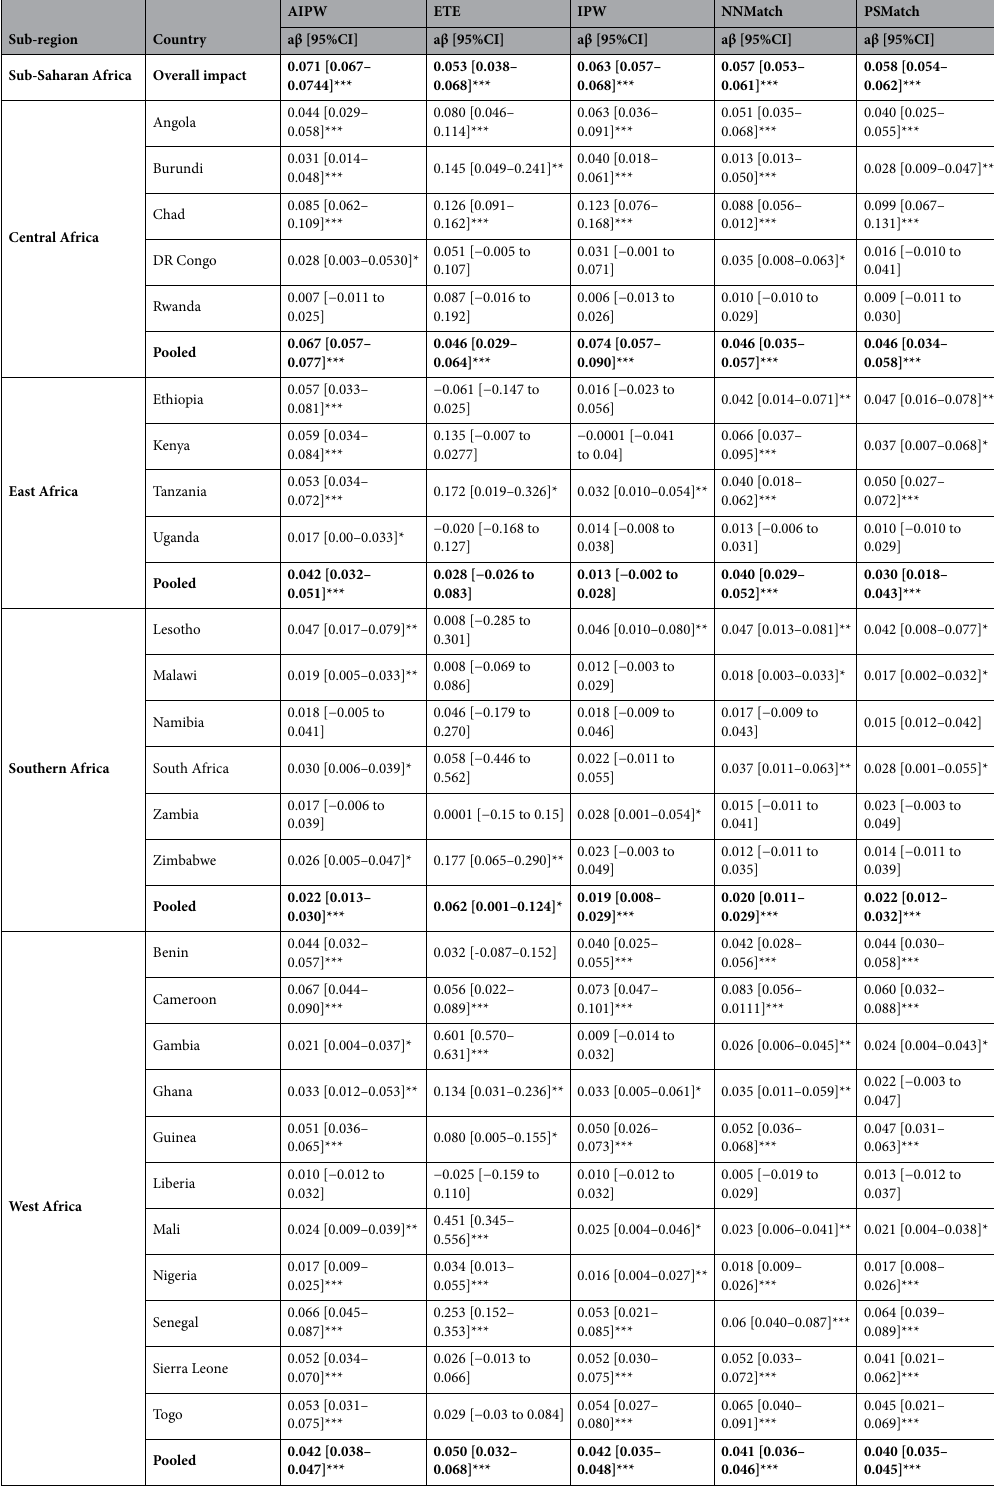
Table 2. Impact of exposure to family planning messages on contraceptive use among women in their reproductive year in Sub-Saharan Countries, evidence from DHS study. Analysis adjusted for; the age of household head, sex of household head, wealth index, place of residence, religion, respondent age, marital status, educational level, currently working, and the number of children ever born. DHS Demographic Health Survey, AIPW augmented inverse probability weighting, ETE endogenous treatment effects, IPW inverse probability weighting, NNMatch nearest neighborhood matching (1:1), PSMatch propensity score matching (1:1), aβ adjusted coefficient estimate, CI confidence interval. P-value notation: *p-value < 0.05, **p-value < 0.01, ***p-value < 0.001. Values in bold highlight the estimates at the regional block